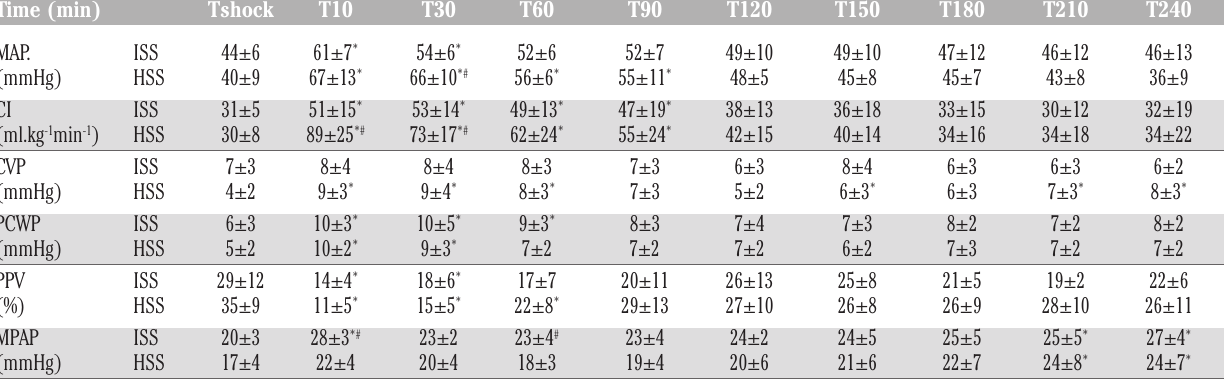
Table 2. Hemodynamic variables during fluid administration. After induction of peritonitis, septic shock corresponded to T shock, when pigs were resuscitated either with (HSS-HES) hypertonic saline 7.2%/hydroxyethyl starch or (ISS-HES) isotonic saline 0.9%/hydroxyethyl starch.